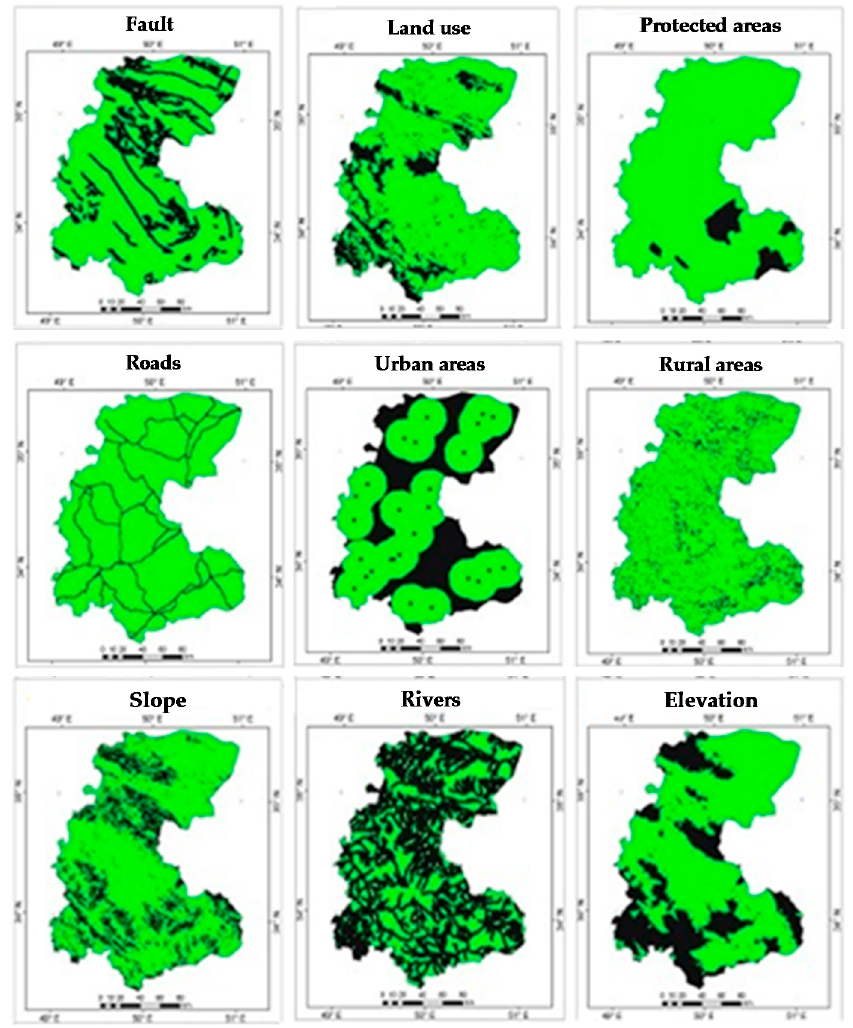
Figure 4. The restricted areas eliminated by Boolean